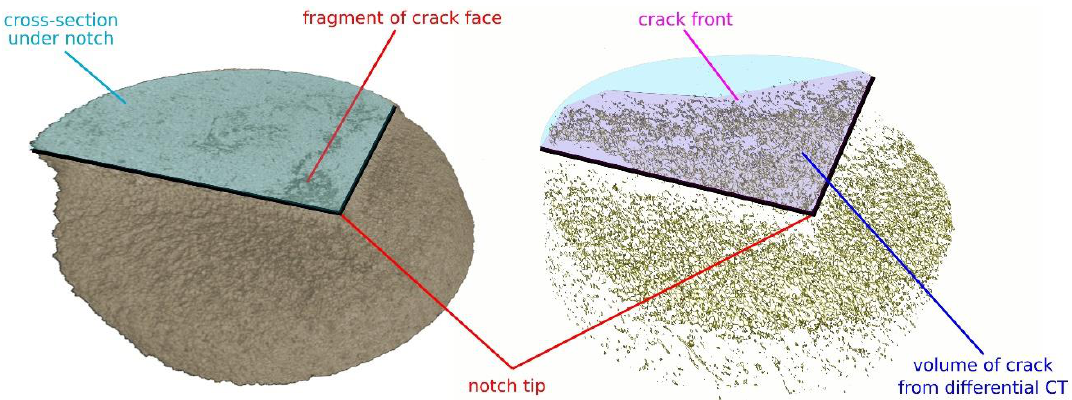
Figure 8. The schematics of the tomographic visualisation in the region of the notch (CT4 (wet) loading state, left), the 3D difference between the CT4 (wet) and CT0 (wet) (right).